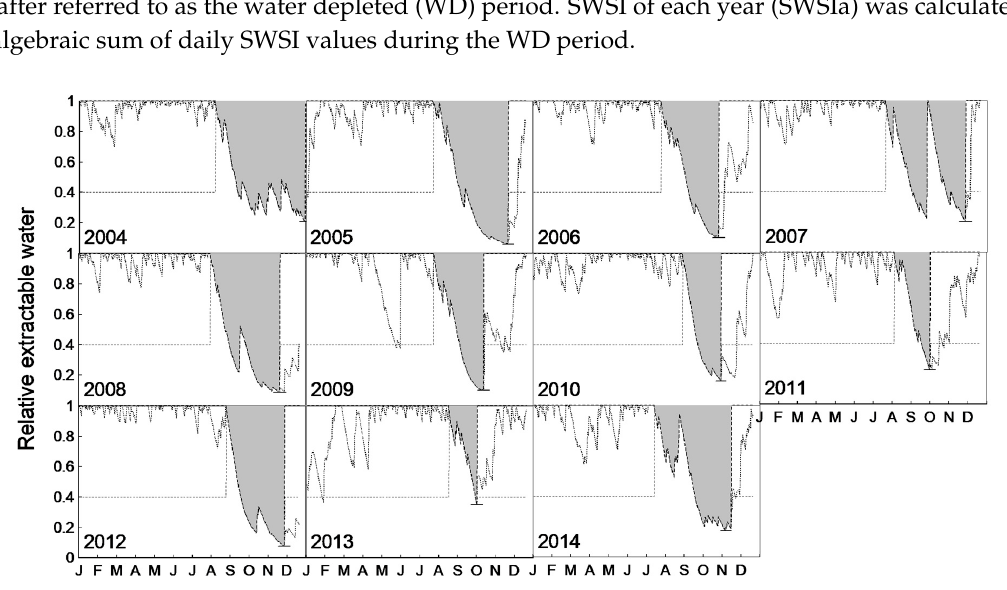
Figure 1. Seasonal variations in relative extractable water (REW) for each year (2004–2014). The water depletion period (WD, gray shaded area) is characterized by REW dropping from its field saturation point (REW < 1~0.4, dotted line), passing through its threshold level (REW = 0.4, short thin straight dashed line), down to its lowest point (solid line at the bottom of the lowest REW level).